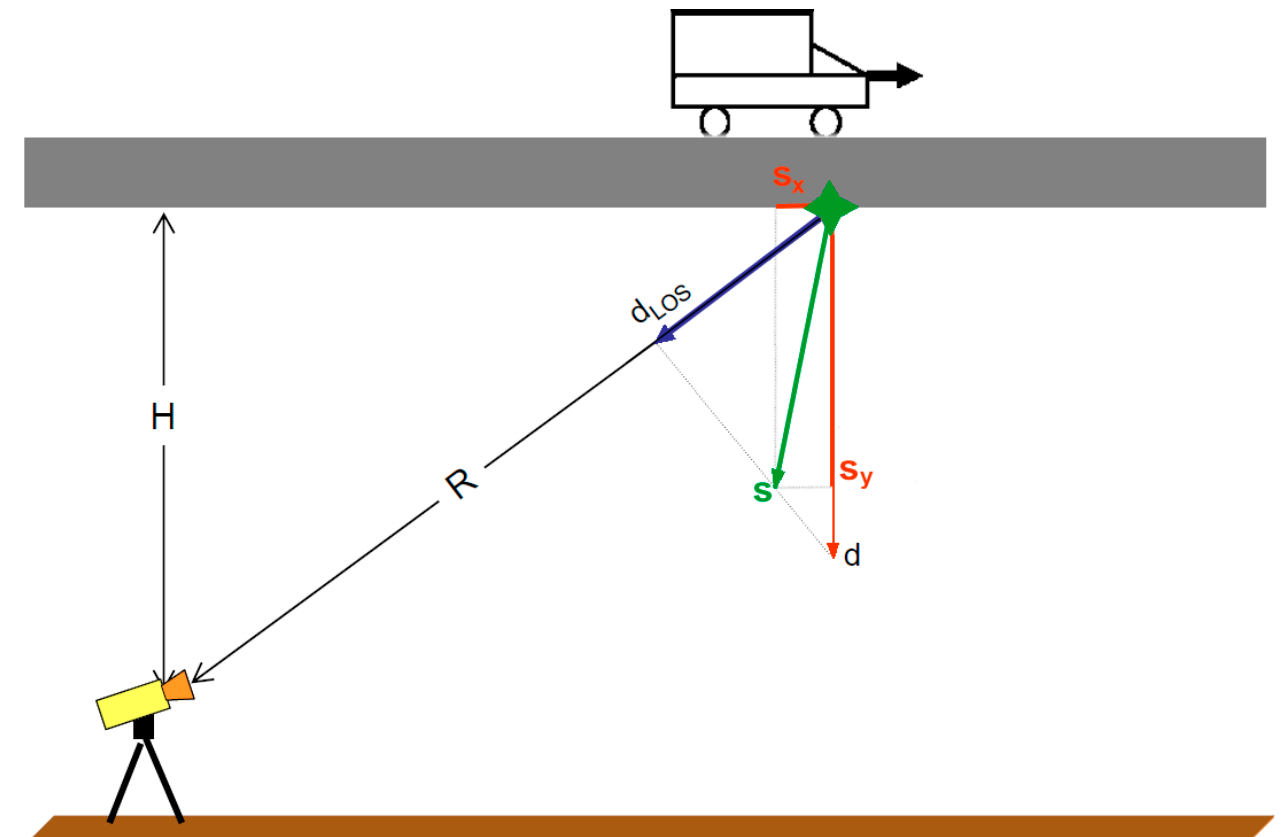
Figure 2. Origin of the Interpretation Error E I when measuring with only one interferometric radar: s—total displacement; s y —vertical component of total displacement; s x —horizontal component of total displacement; d LOS —measured displacement in the range direction; d—calculated vertical displacement; R—radar distance from the measured point; H—radar distance from the measured point in vertical direction.